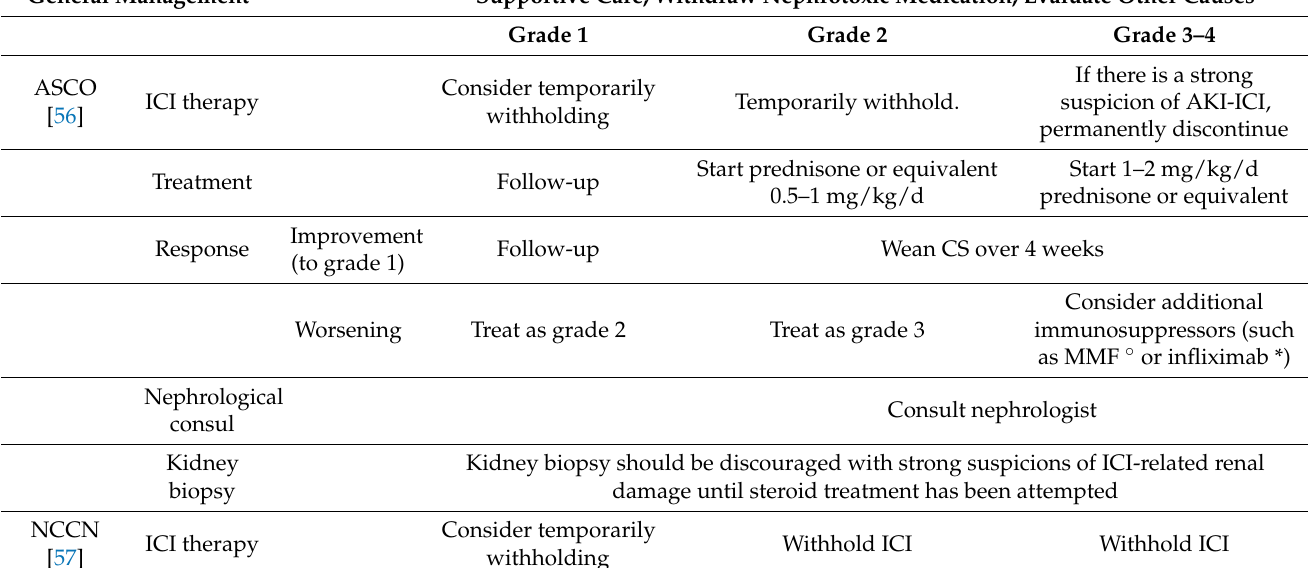
Table 4. Management of AKI in patients undergoing ICI therapies, according to national and international guidelines. Legend: ASCO, American Society of Clinical Oncology; NCCN, National Comprehensive Cancer Network; SITC, Society for Immunotherapy of Cancer; ESMO, European Society for Medical Oncology; AIOM, Italian Association of Medical